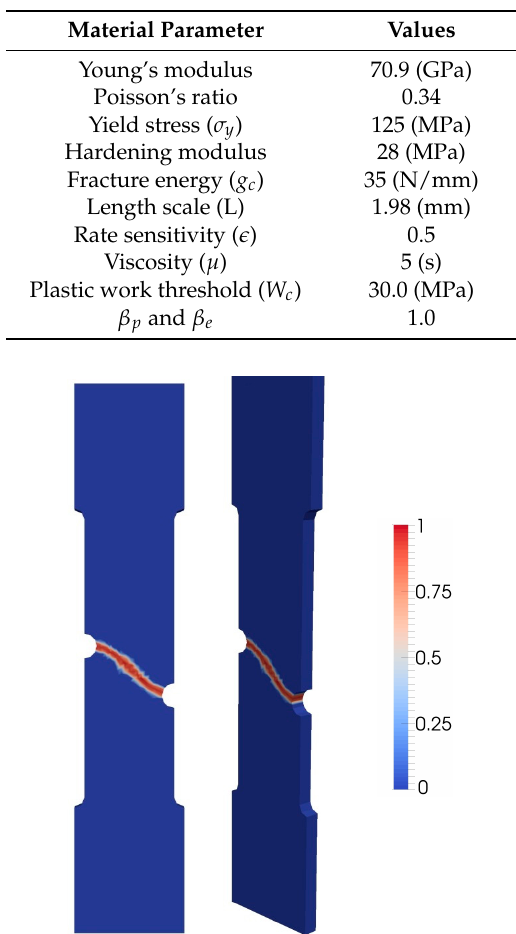
Figure 12. Contour plots of the phase field for the asymmetric notched sample.